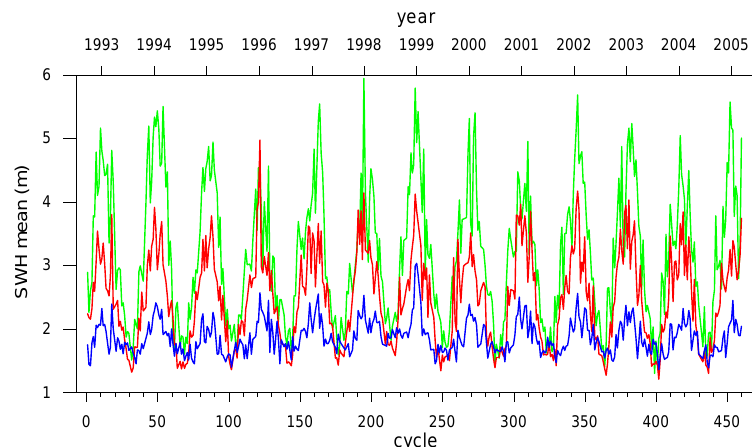
Figure 13a – Average SWH. blue - Tropical; red : Sub-Tropical; green: Sub-Arctic.